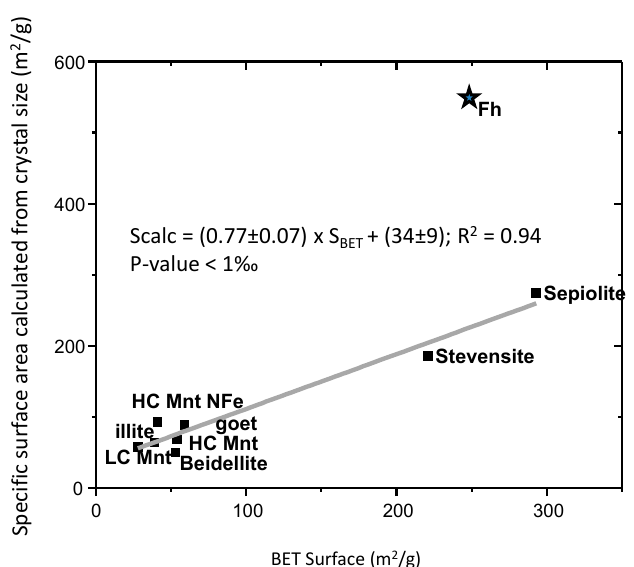
Figure 4. Specific surface area of the different geosorbents comparing Brunauer, Emmett and Teller (BET) method nitrogen adsorption measurements and calculated surface area by crystal size XRD determination based on crystallographic symmetry and XRD reflection breadth measurements. Linear fit excludes ferrihydrite (Fh). Materials: Sepiolite: Pansil ® ; Stevensite: Minclear 100 ® ; HC Mnt: FEBEX high-charge montmorillonite; HC Mnt NFe: Mnt-Chile High-charge montmorillonite, low Fe content; Goet: Synthetic Goethite; Fh: Synthetic Ferrihydite; Sewage S.: Calcined Sewage